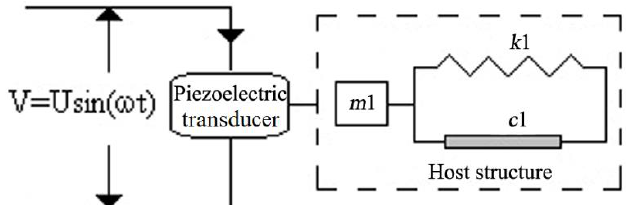
Figure 1. One-dimensional interaction model of the piezoelectric transducer and host structure. V: the instantaneous voltage; U: maximum value of voltage; ω : angular frequency; t: time; c1: damper; k1: spring; m1: mass.